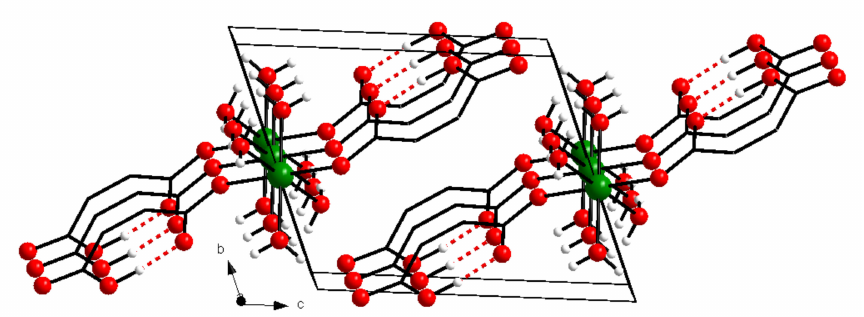
Figure 2. Stabilization of the crystal structure by strong intermolecular hydrogen bonds in